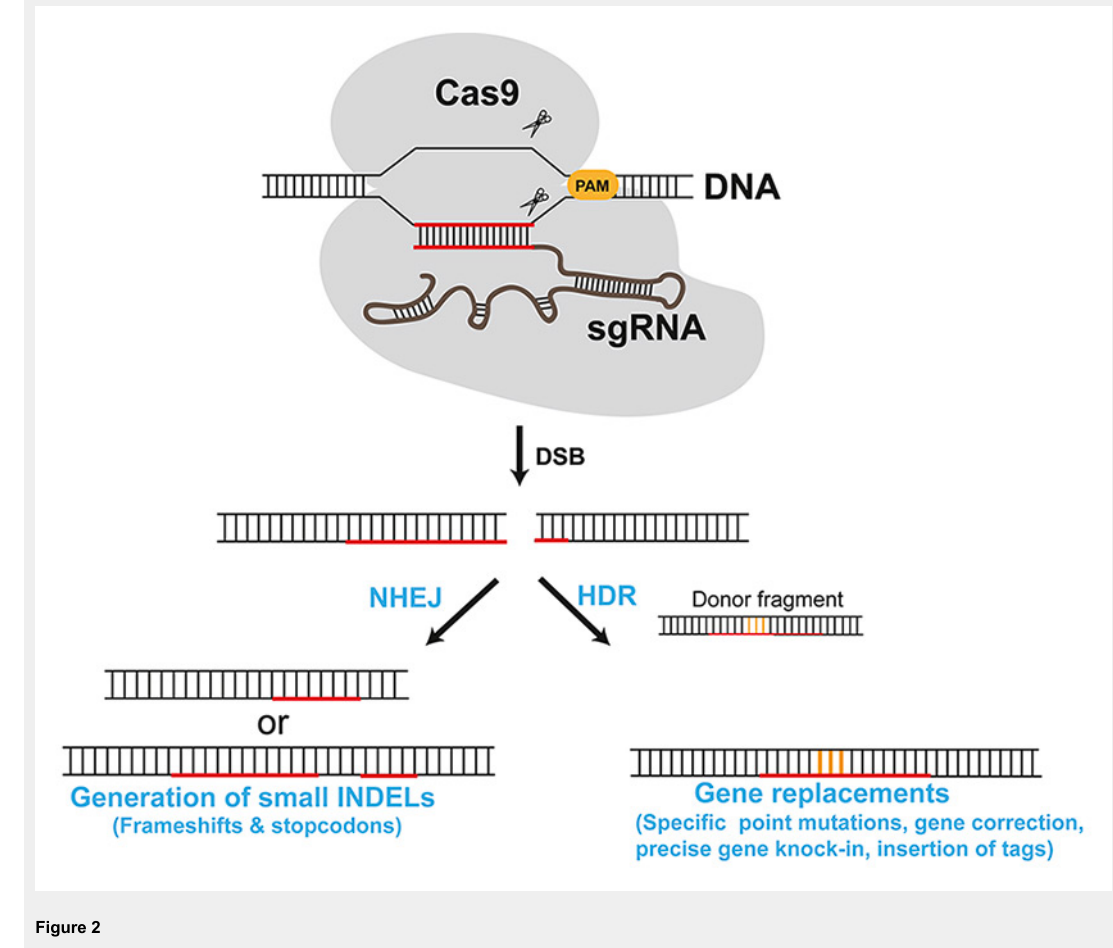
Figure 2 Genome editing by CRISPR-Cas9. Schematic of possible outcomes of CRISPR-Cas9-induced DSBs. Repairing via non-homologous end joining (NHEJ) generates indels, while repair via homologous recombination in the presence of an appropriate donor fragment can be used to introduce specific genetic changes (in orange). The sequence recognized by the sgRNA is in red. The location of the protospacer adjavent motif (PAM) in the target site is also